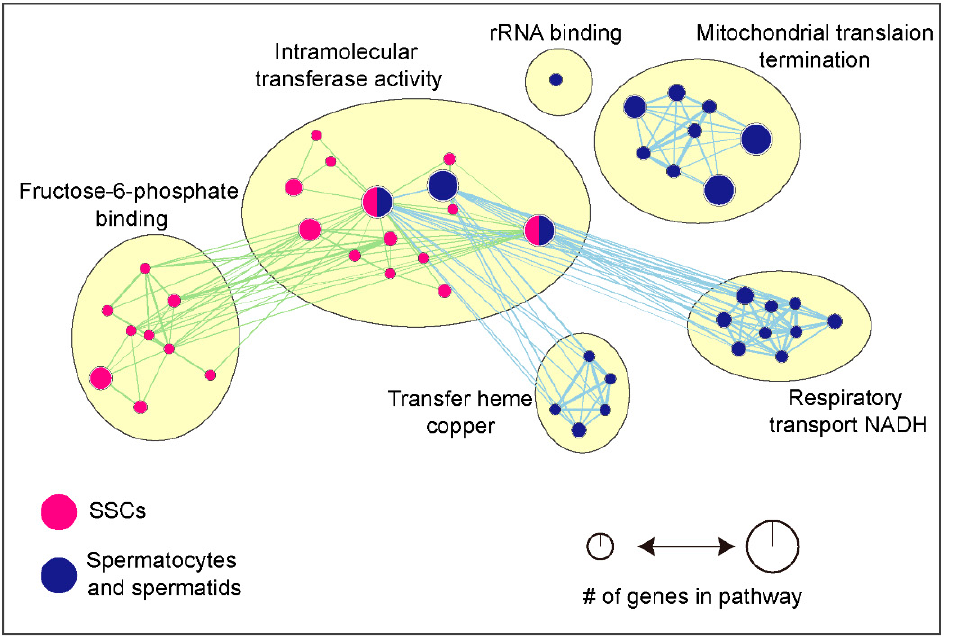
Figure 2. Signaling Pathways According to Differentially Expressed Genes between Spermatogonia and Spermatocytes/Spermatids. Molecular functions based on the differentially expressed genes in spermatogonia (SSCs) and differentiated male germ cells (spermatocytes and spermatids) were determining using g: Profiler, Cytoscape, and EnrichmentMap. Purple represents enrichment in spermatogonia, while blue represents enrichment in differentiated male germ cells. Node size indicated how many genes are involved to pathways. Table 1. Summary of differentially expressed genes between spermatogonia and spermato- cytes/spermatids.